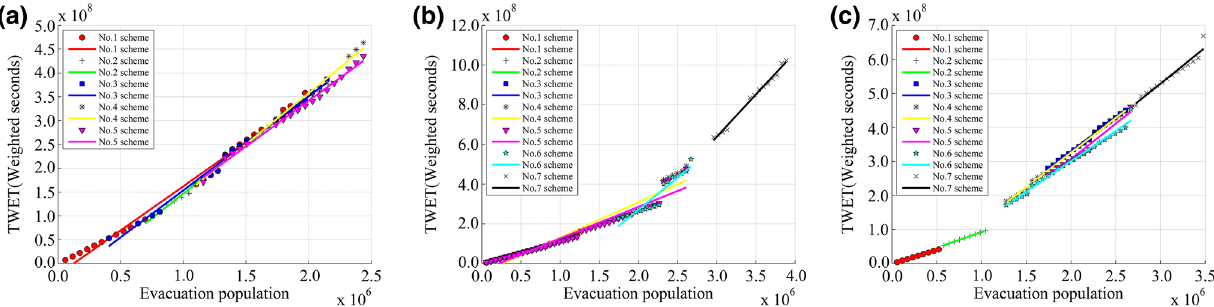
Fig. 5 Relationships between evacuation population and total weighted evacuation time (TWET) with different total shelter areas (TSAs). a – c Location 1, Location 2, and Location 3,